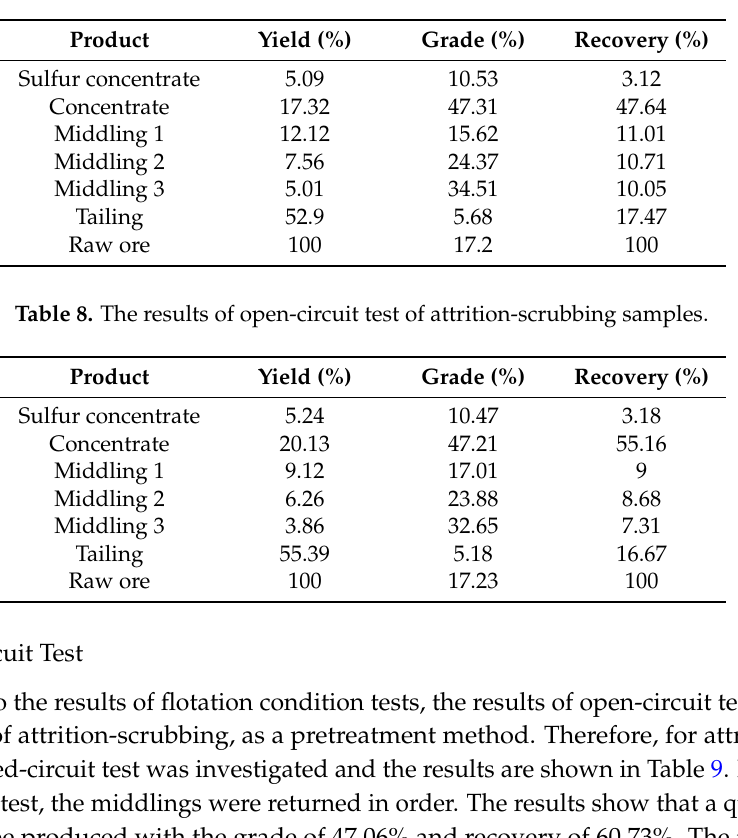
Table 7. The results of open-circuit test of samples without attrition-scrubbing.